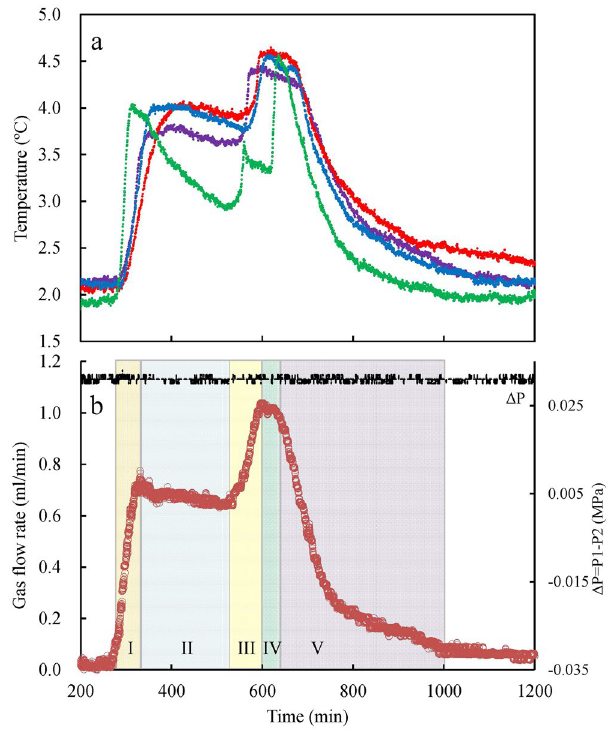
Figure 1. Temperature and gas flow rate during the methane hydrate formation process as a function of time at 1.45 °C. The temperatures at points T1, T2, T3, and T4 are denoted by the purple, red, blue, and green lines ( a ), respectively. The black line in ( b ) shows the pressure difference between P1 and